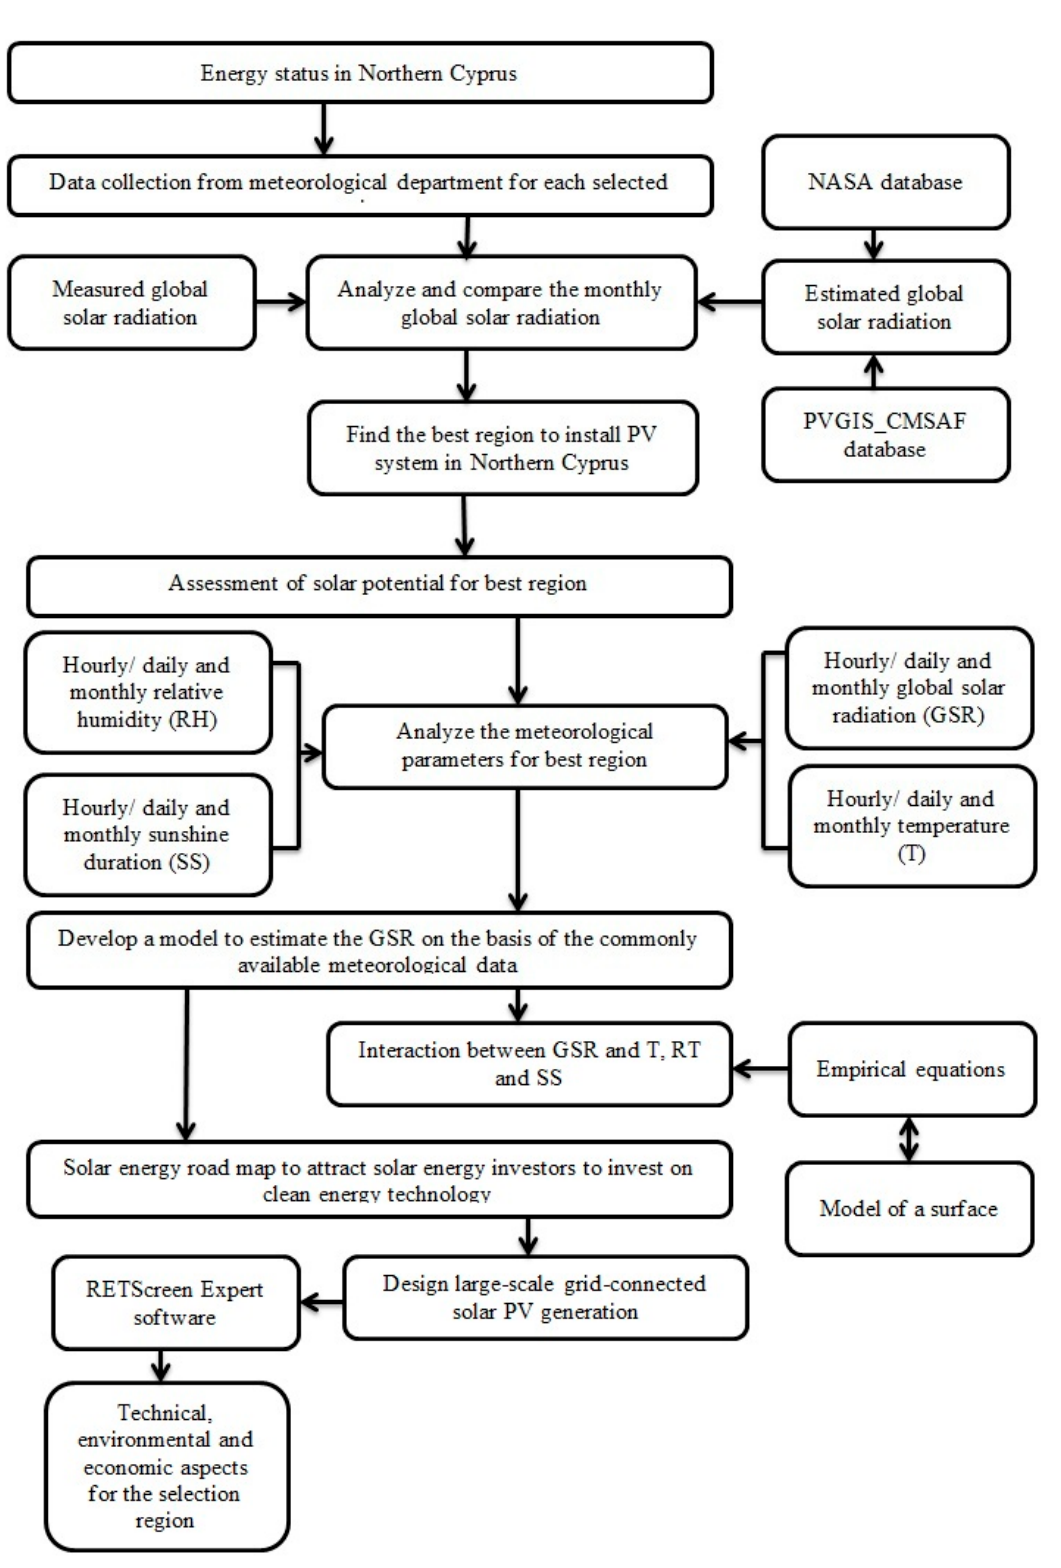
Figure 3. Flowchart of the analysis procedure of the present study.